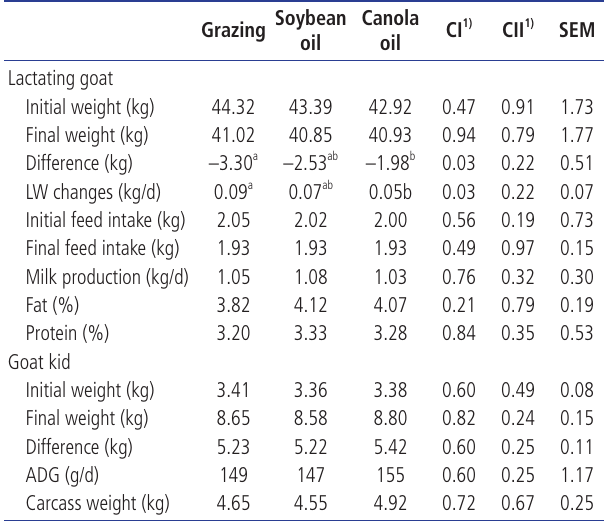
Soybean Canola Grazing CI 1) oil oil